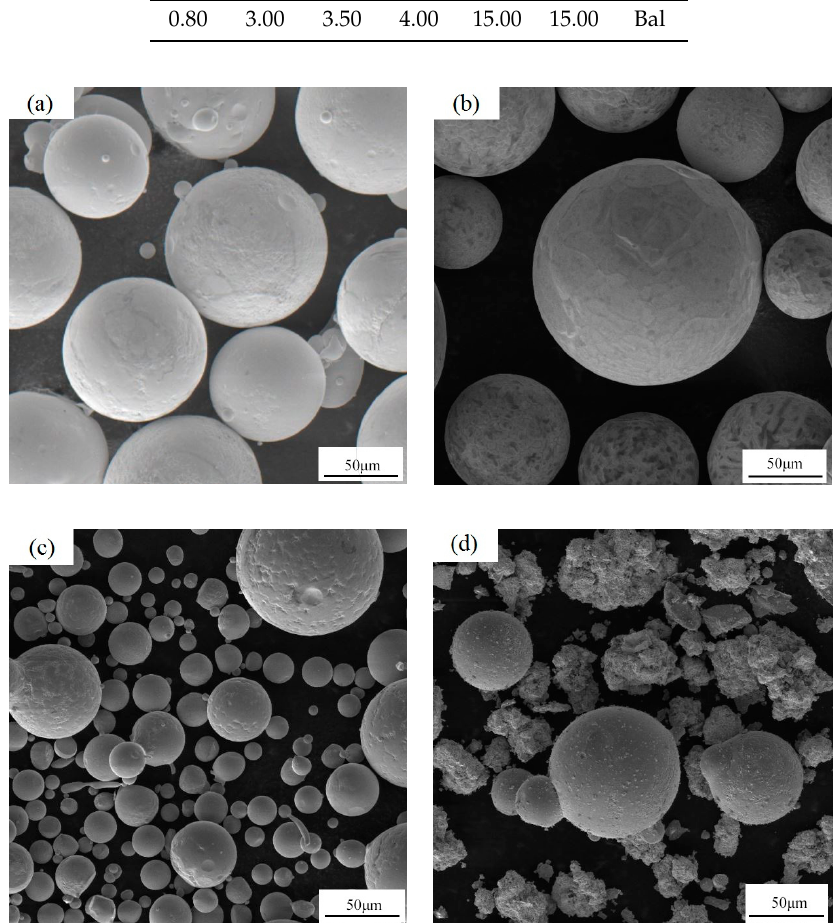
Figure 1. Scanning electron microscopy (SEM) images of ( a ) Ni60, ( b ) Ni60-spherical WC, ( c ) Ni60-shaped WC and ( d ) Ni60-flocculent